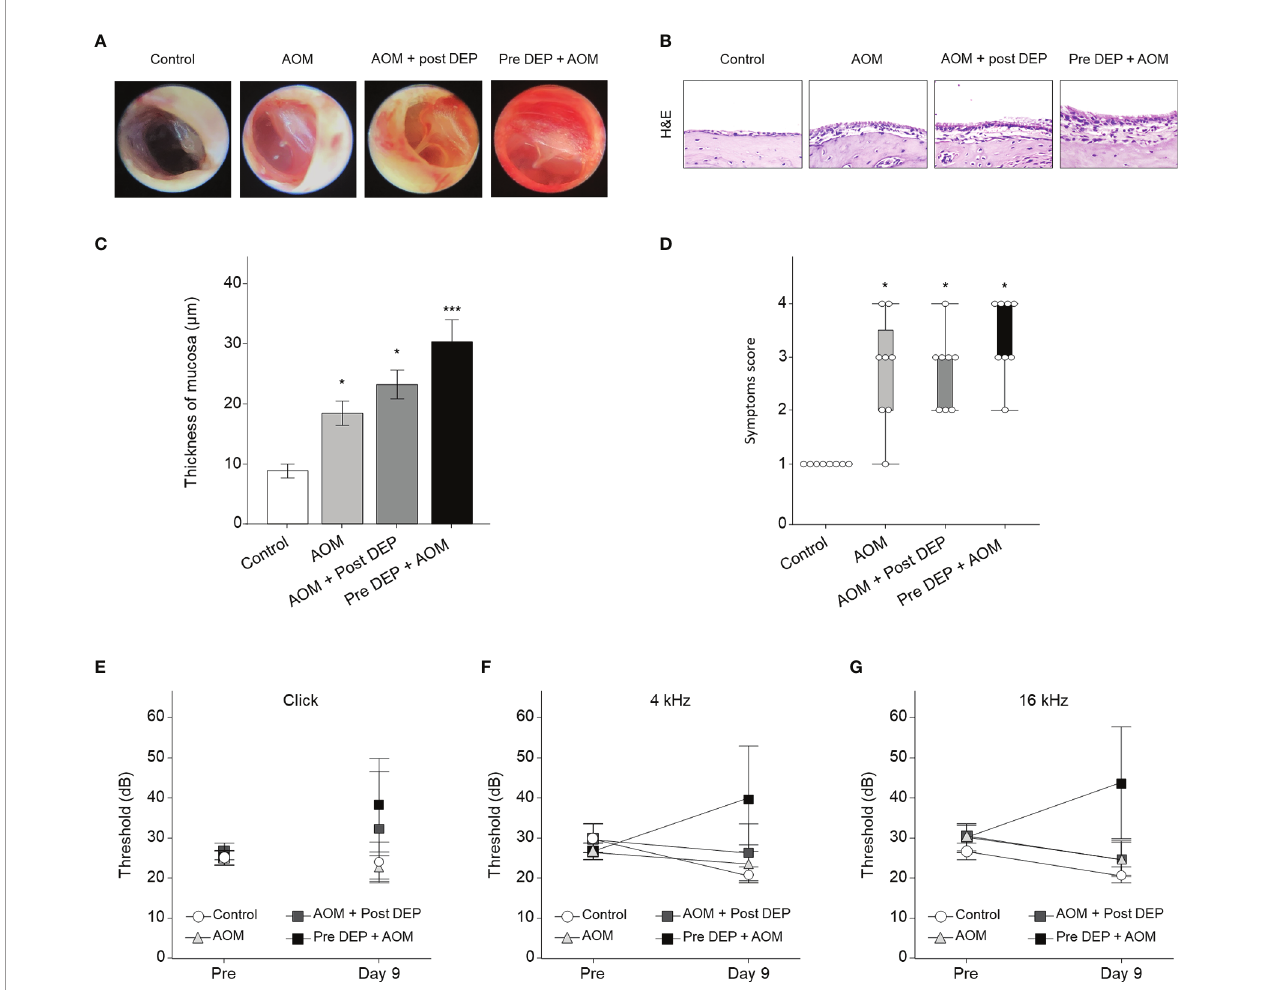
FIGURE 3 | Acute otitis media symptoms and H&E staining analysis of the middle ear in LPS + DEP exposure mouse. (A) Otoscope images of the tympanic membrane before sacri fi ce. (B) H&E staining of middle ear pathology. (C) The thickness of the middle ear epithelium is higher in the DEP + LPS exposure group. (D) The symptom score is higher in the acute otitis media group. (E – G) Auditory brainstem response threshold changes in the mouse model. The same location shown in each slide was chosen (H&E, magni fi cation ×400). *p < 0.05, compared with the control group; ***p < 0.05 compared to the AOM group. LPS, lipopolysaccharide; DEP, diesel exhaust particles; H&E, hematoxylin and eosin; AOM, acute otitis